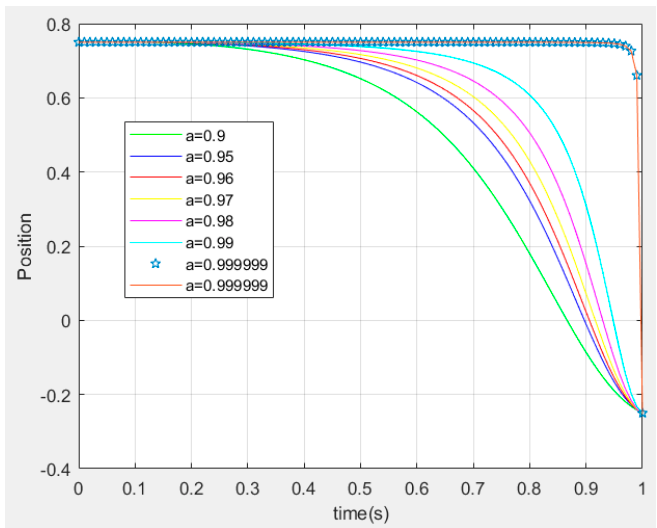
Figure 4. Different examples of trajectories for when a approximates to t s = 1. This property is only presented when the total time of the trajectory is equal to 1 (cid:12) (cid:12) ( x + 1 − 1 ) − n a (cid:12) (cid:12) because x (cid:12) n (cid:12) is not enough small for when x is 0 draw the function g ( x ) = n x − ζ and h ( x ) = n ( x + 1 x − 1 ) − n a to get a better idea). However, a curved motion can be obtained even when the total time is greater than 1, for example in Figure 5, different curved motions are